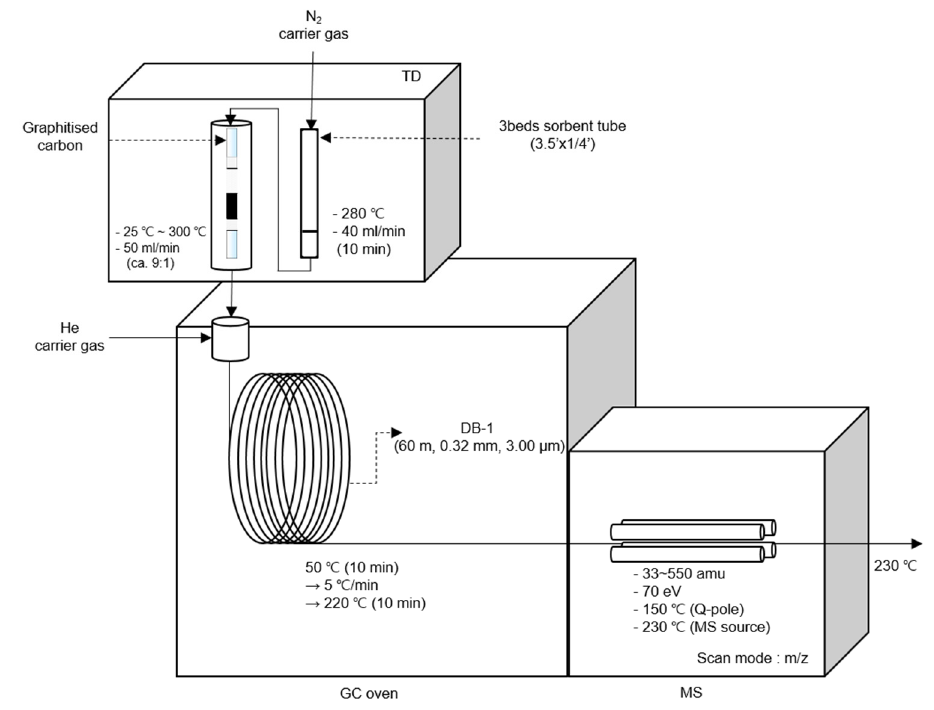
Figure 1. Operating conditions of thermal desorption and GC/MS used for VOCs analysis.